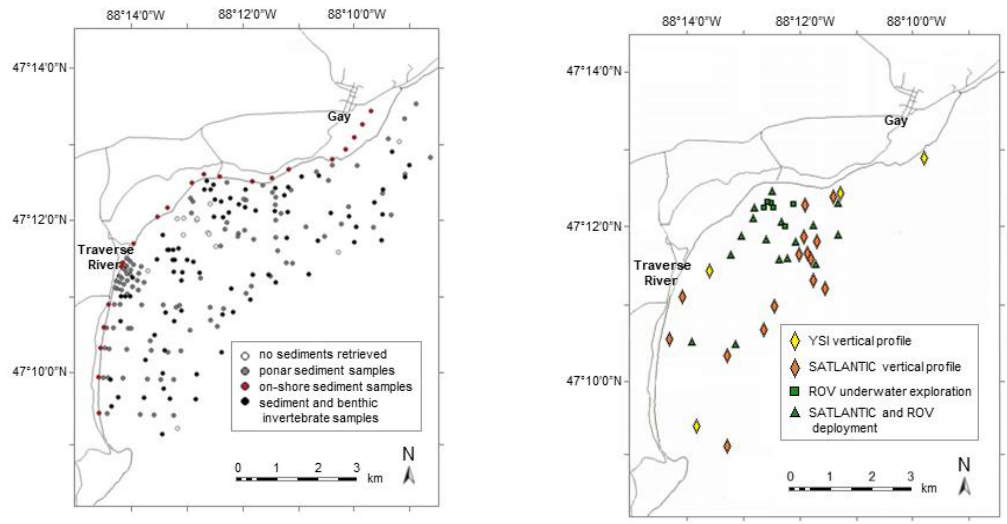
Figure 5. Sampling sites in Grand Traverse Bay: Ponar sediment sampling sites ( left ), 2013. Grey dots mark sediment samples primarily for grain size characterization, black dots for % stamp sand and copper concentration calculations and red dots for beach reference samples. YSI, Satlantic and ROV sites ( right ). The YSI was used for vertical column water quality measurements.